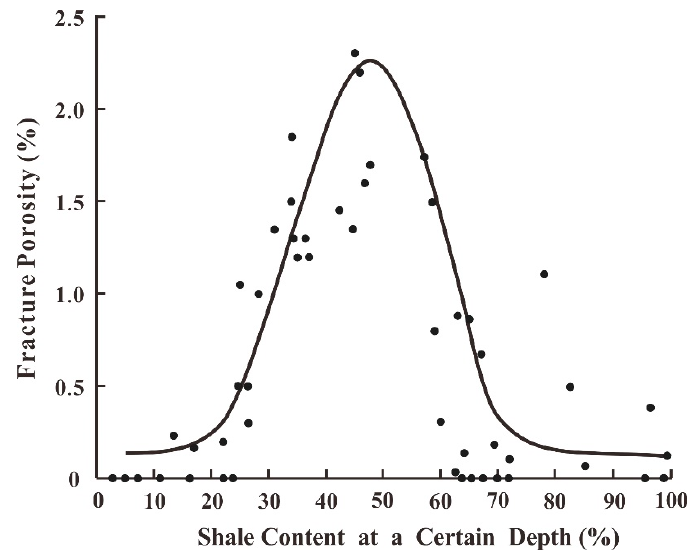
Figure 3. The relationship between fracture porosity and shale content.